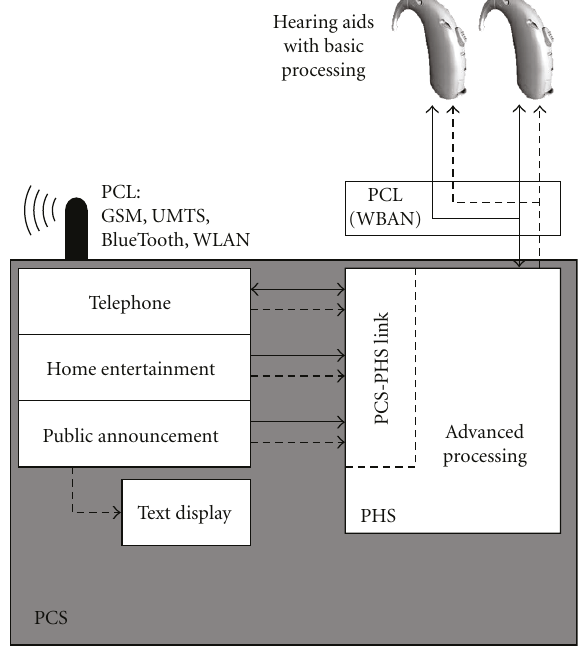
Figure 1: Architecture of a Personal Communication System (PCS) hosting the personal hearing system. The PCS (large shaded box) is hosted on an advanced mobile phone. The Personal Hearing System (PHS) is a software component for signal enhancement, processing audio output of the PCS communication channels and processing environmental signals. The Personal Communication Link (PCL) transfers environmental sounds to the PHS and the processed sounds or control information back to the audio